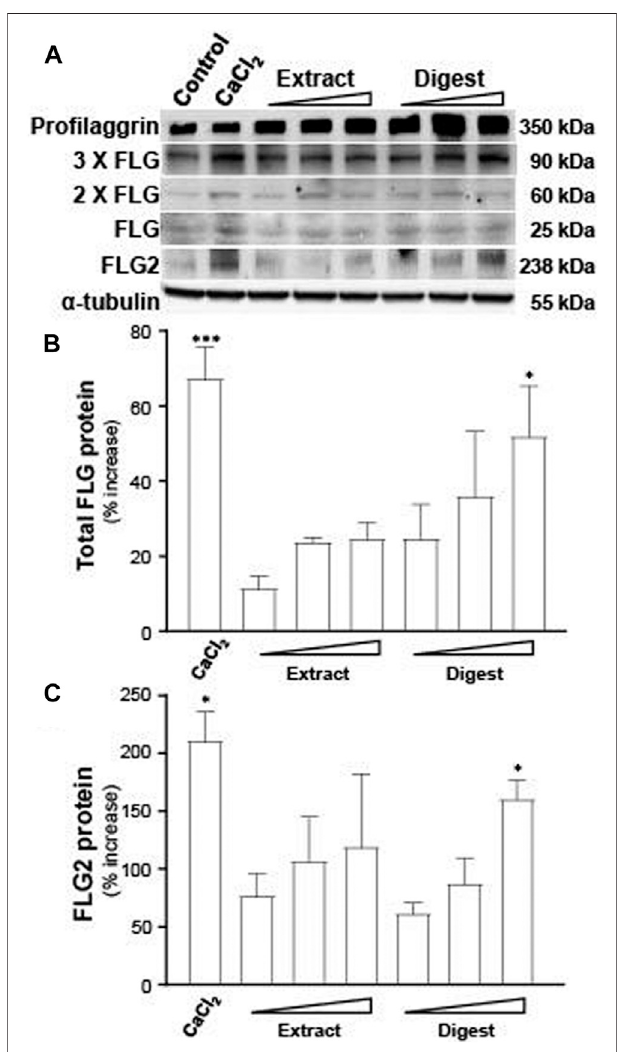
FIGURE4| EBNinducestheproteinlevelsof fi laggrinand fi laggrin-2. (A) The protein levels of fi laggrin (FLG) and fi laggrin-2 (FLG2) in cultured differentiated keratinocytes, after 24-h treatments of EBN extract and digest, were determined in doses of 1, 10, 100 μ g/mL, as indicated. CaCl 2 at 0.16 mM wasadopted asapositivecontrol. (B) The total fi laggrin(summation of the isomeric intermediates) and (C) fi laggrin-2 protein levels, relative to α -tubulin protein, are expressed as the percentage increase to normalized basal expression set at 0 in mean ± SEM, n (cid:2) 3. Statistically signi fi cant results are marked with * p < 0.05, ** p < 0.01, and *** p < 0.001 against the control.